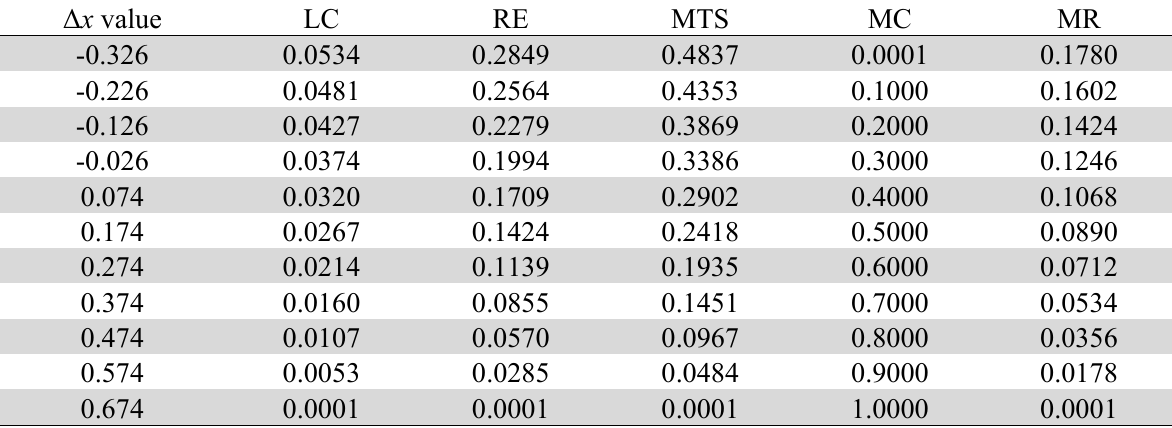
Changing criteria weights for high dimensional weight sensitivity analysis for Example